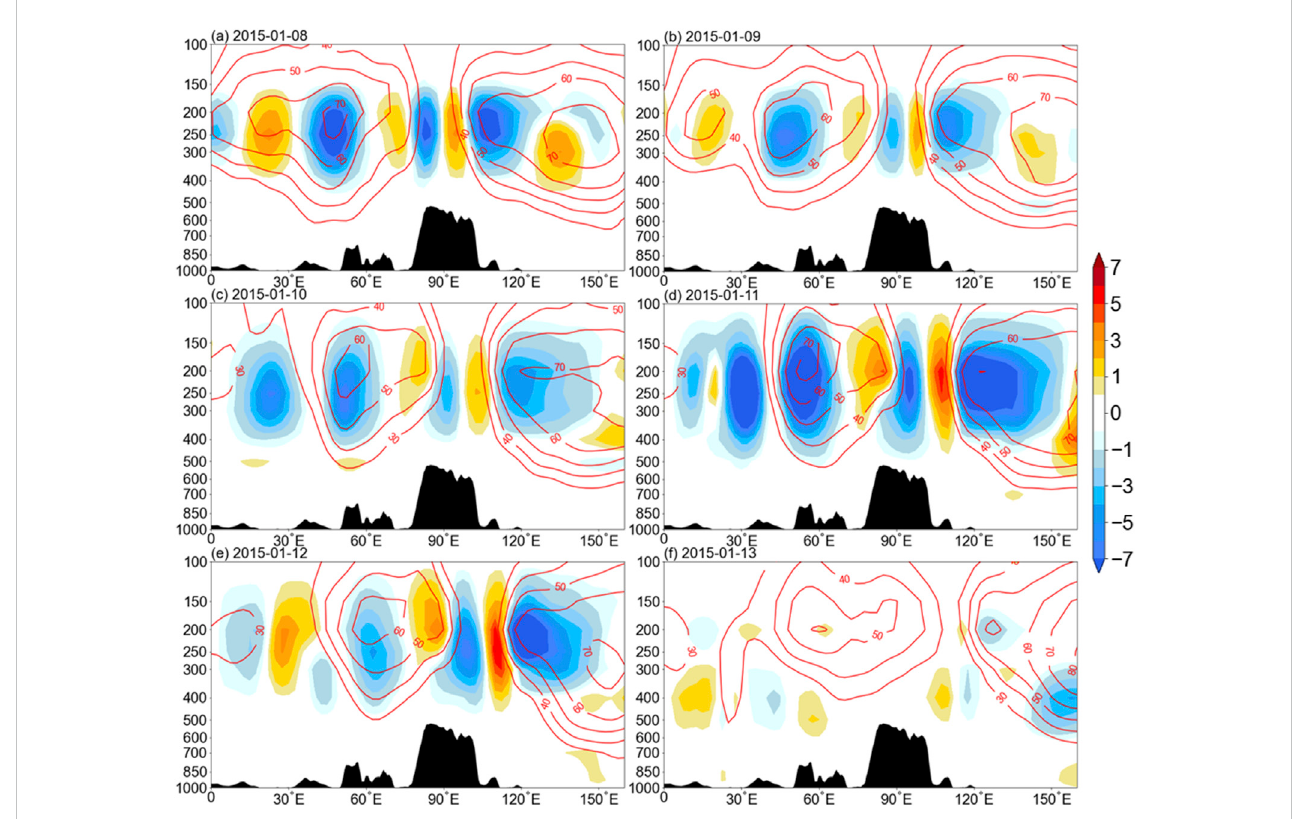
FIGURE 13 The term S A for thetransformation of thezonal mean and wave disturbance kinetic energy (shading; units: 10 – 3 m 2 · s − 3 )along the subtropical westerly jet streamaxisof30 ° NonJanuary (A) 8, (B) 9, (C) 10, (D) 11, (E) 12and (F) 13in2015.Theredcontourindicateszonalwindspeedsgreaterthan30 m · s − 1 .Theblack shading shows the shape of the